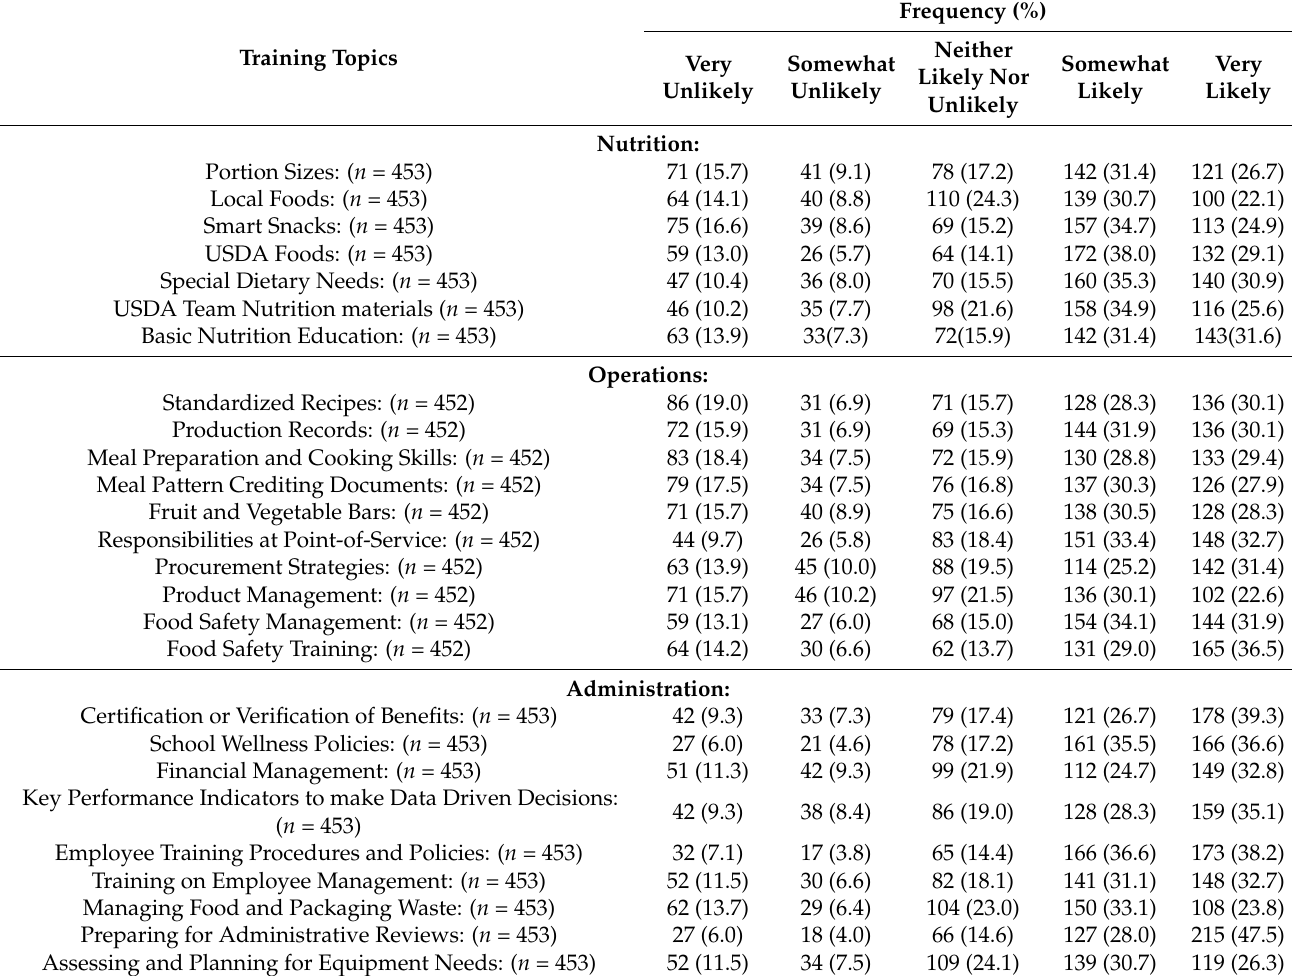
Table 3. Reported Training Topic Preferences of Illinois Child Nutrition Program